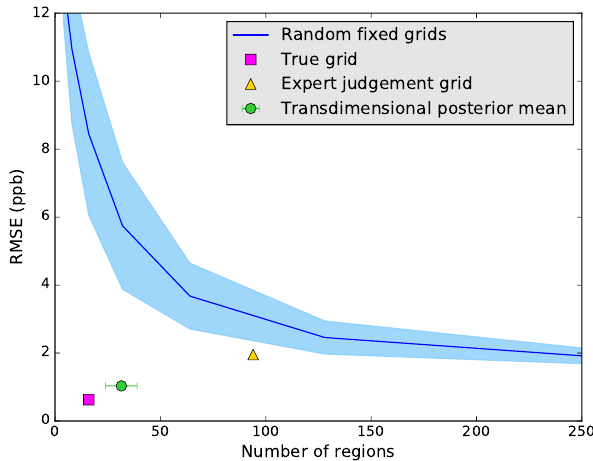
Figure 3. RMSE in the data space as a function of number of un- y true ) . The mean of the transdimen- knowns, given as ( y posterior − sional posterior distribution provides a significantly improved fit to the